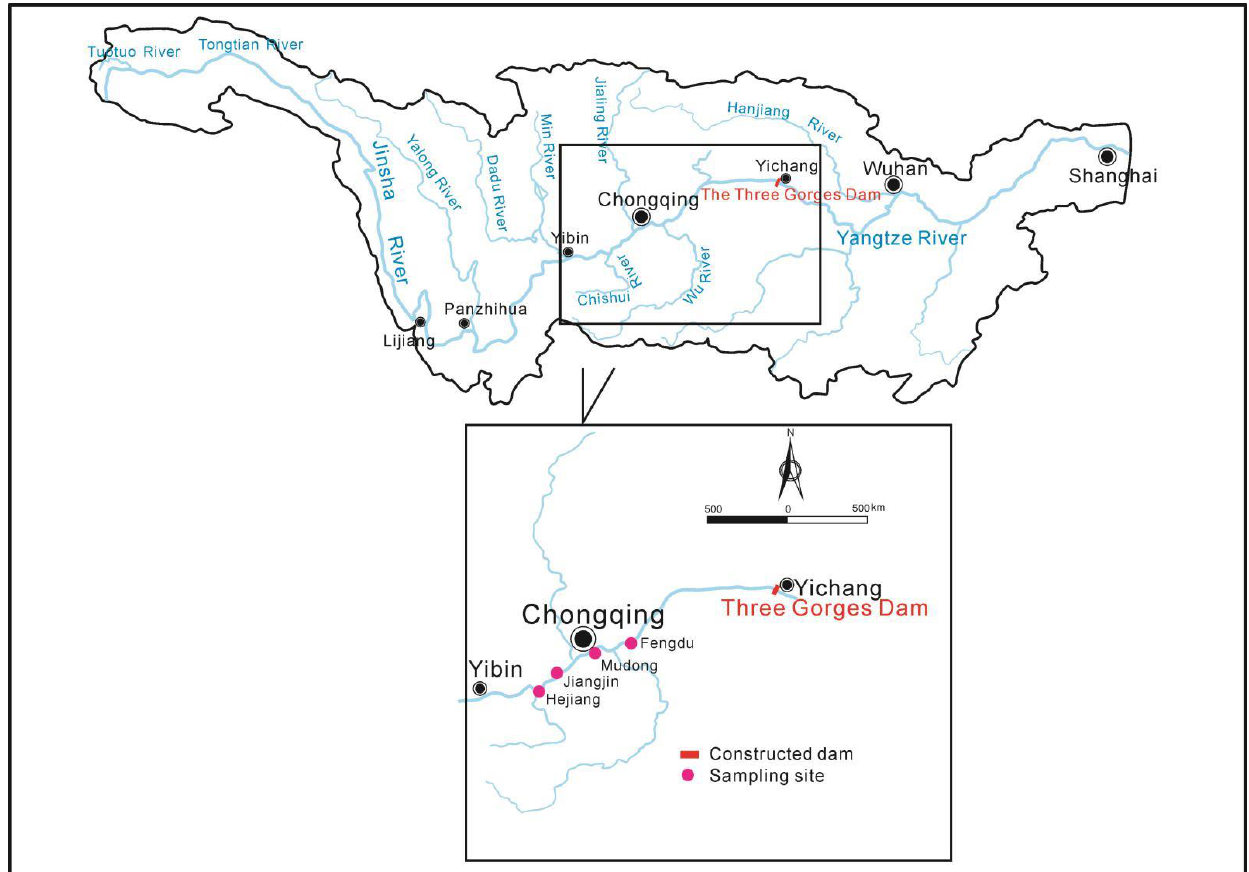
Figure 1. Distribution of sampling sites along the Yangtze River, China. The black dots indicate the cities, and the red dots indicate the sampling sites.